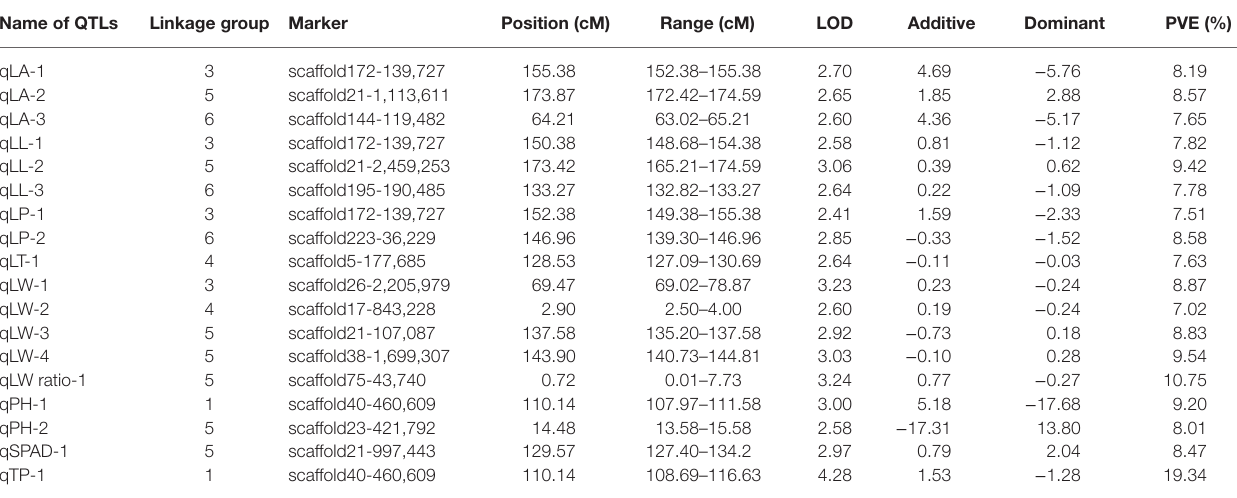
TABLE 4 | Quantitative trait loci